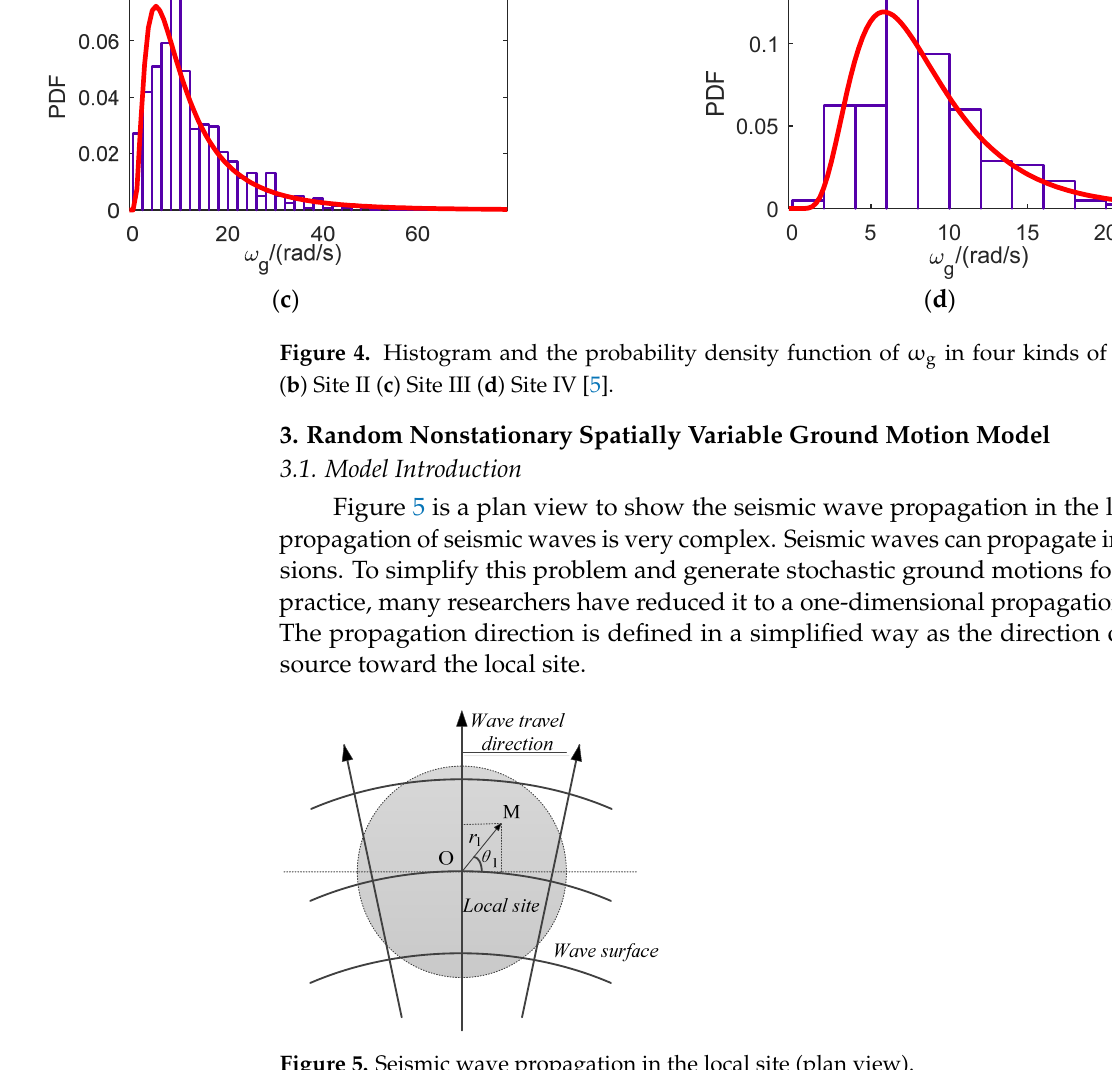
Figure 4. Histogram and the probability density function of ω g in four kinds of sites: ( a ) Site I ( b ) Site Ⅱ ( c ) Site Ⅲ ( d ) Site Ⅳ [5].